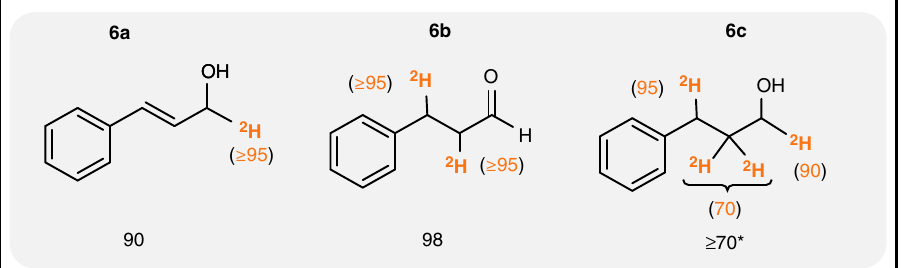
Fig. 3 Scope of asymmetric biocatalytic reductive deuteration. Typical reaction conditions: 0.5 mL, 5 mM reagent, 0.5 mM NAD + , 2 H 2 O (98 %), Tris- 2 HCl (p 2 H 8.0, 100 mM), 1 – 5 vol.% 2 H o C, 1 bar H 6 -DMSO, 16 h, 20 2 and shaking at 500 r.p.m. Catalysts: Excess NADH-dependent reductase, 400 carbon (160 pmol hydrogenase, 260 pmol NAD + reductase). For reductive amination reactions: 25 mM NH 4 Cl. *All transformations were fully selective for the reduction of the desired functional group except 6c , for which a known enzymatic side reaction yielded an extra product (see Supplementary Fig. 47 and associated discussion). Full experimental and analytical details are provided in Supplementary